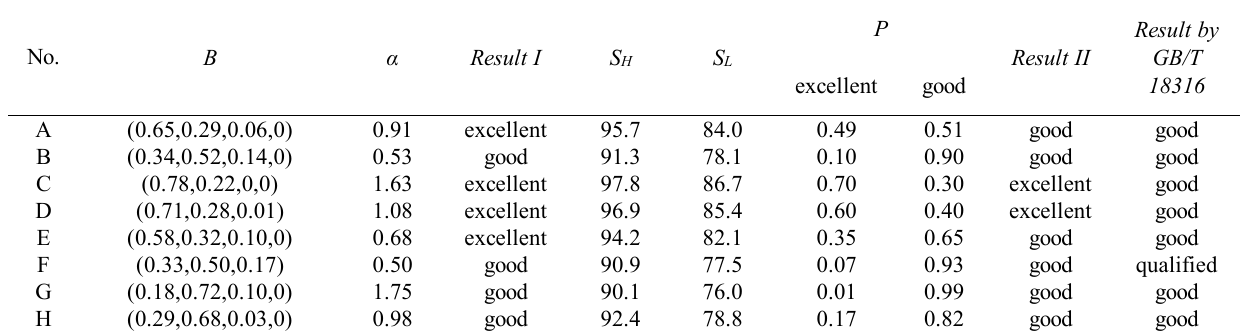
Table 4. Comparison of evaluation